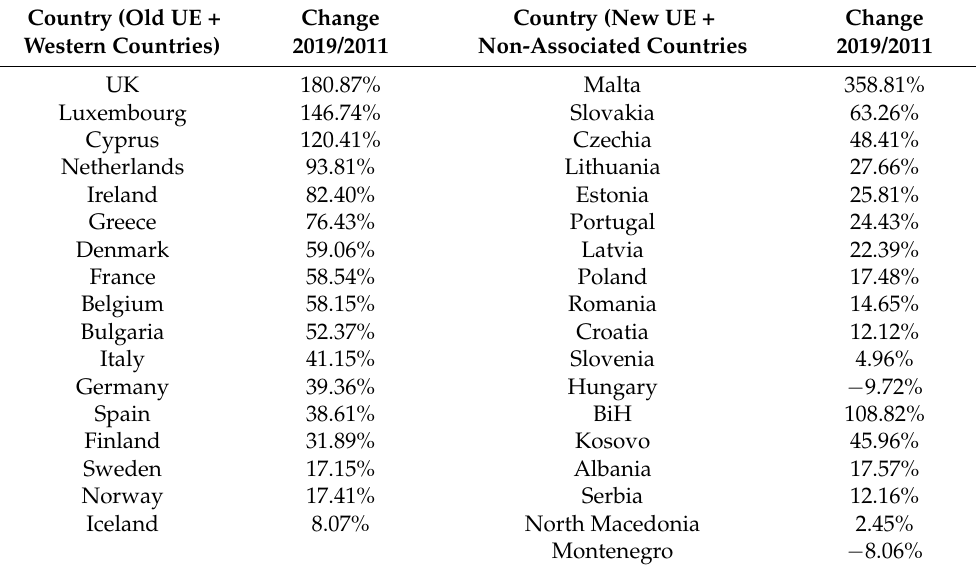
Table 7. Change in the share of renewable energy in gross final energy consumption 2019 compared to 2011